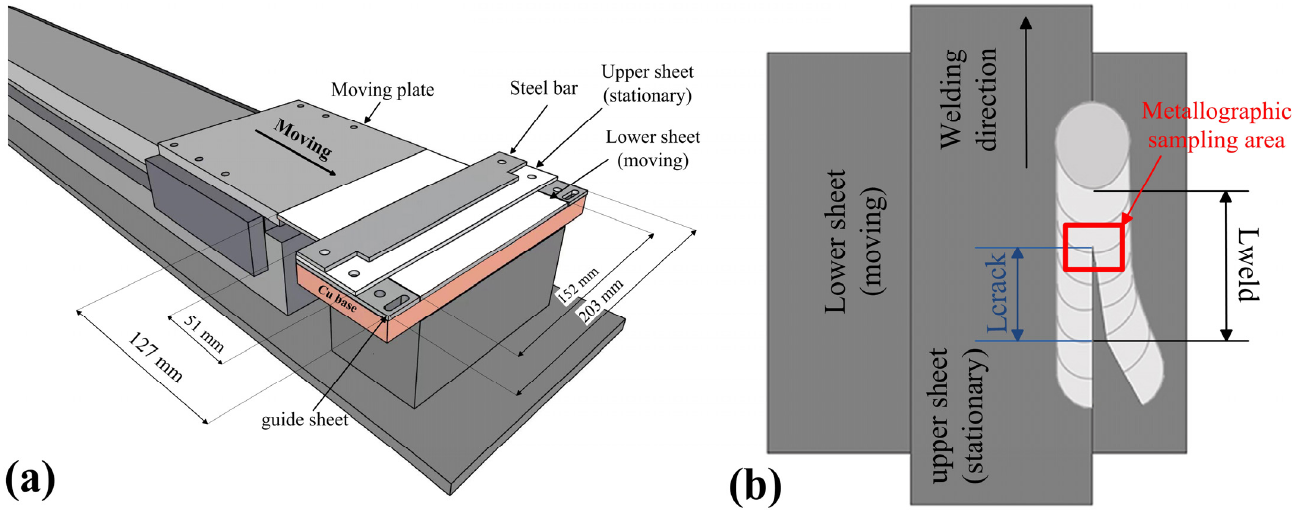
Figure 1. Apparatus for the present crack susceptibility test: ( a ) local dimension diagram; ( b ) calibration of sensitivity to solidification crack.